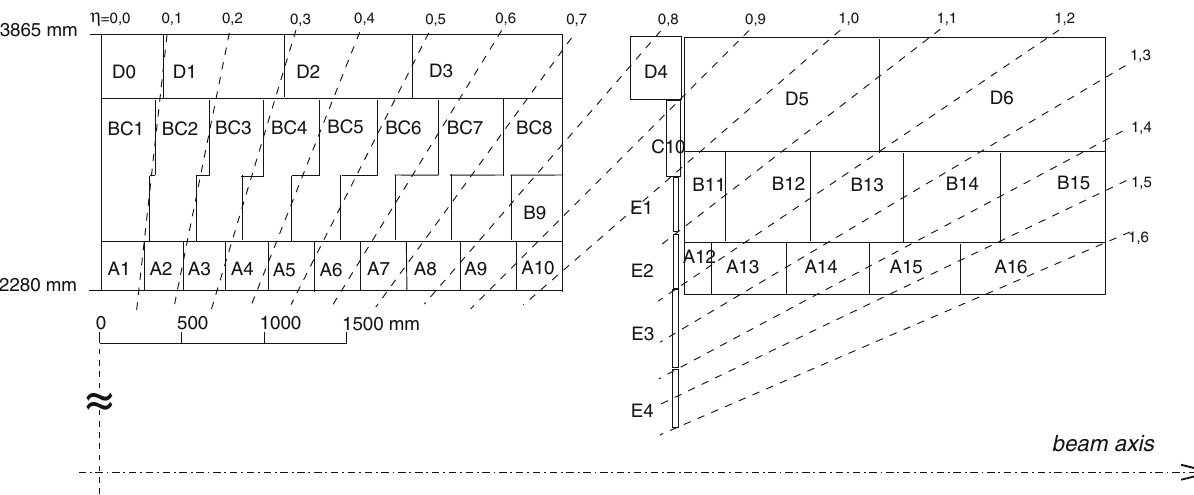
Fig. 1 The layout of the TileCal cells, denoted by a letter (A to E) plus an integer number. The A-layer is closest to the beam-line. The naming convention is repeated on each side of η =